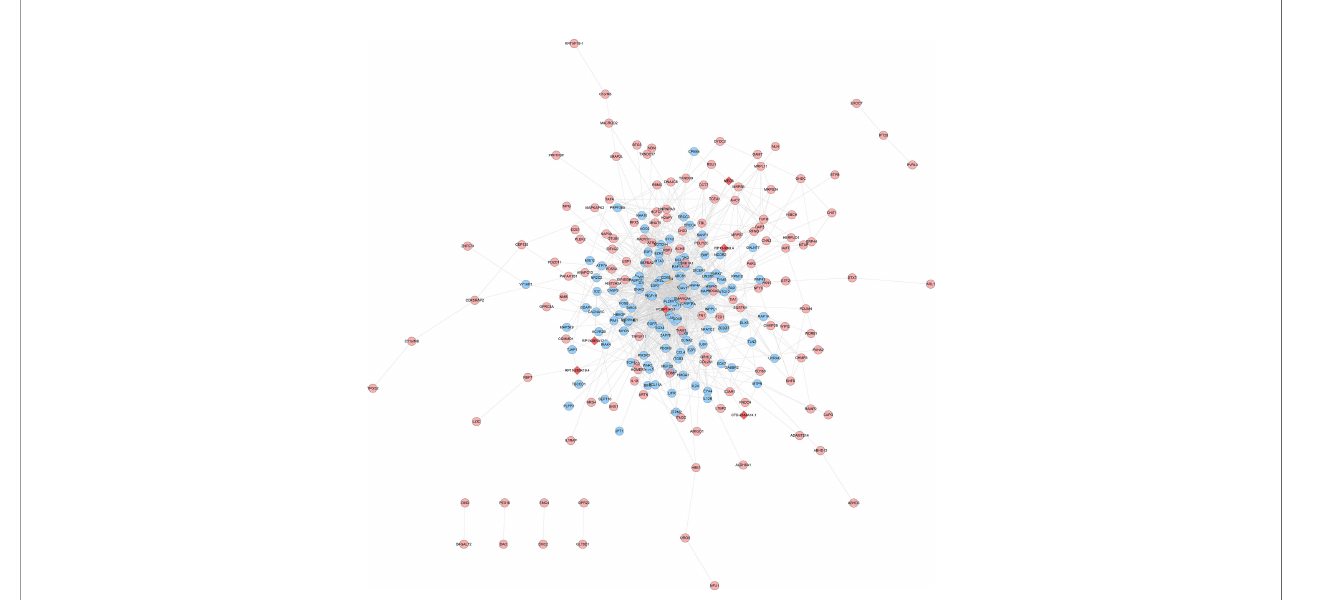
FIGURE 13 | LncRNA-mRNA co-expression network of the disease group after treatment/before treatment (Red diamonds represent lncRNA. Blue, pink, and orange circles represent mRNA predicted by the lncRNA, mRNA detected by the experiment and mRNA that interacts with lncRNA, respectively).